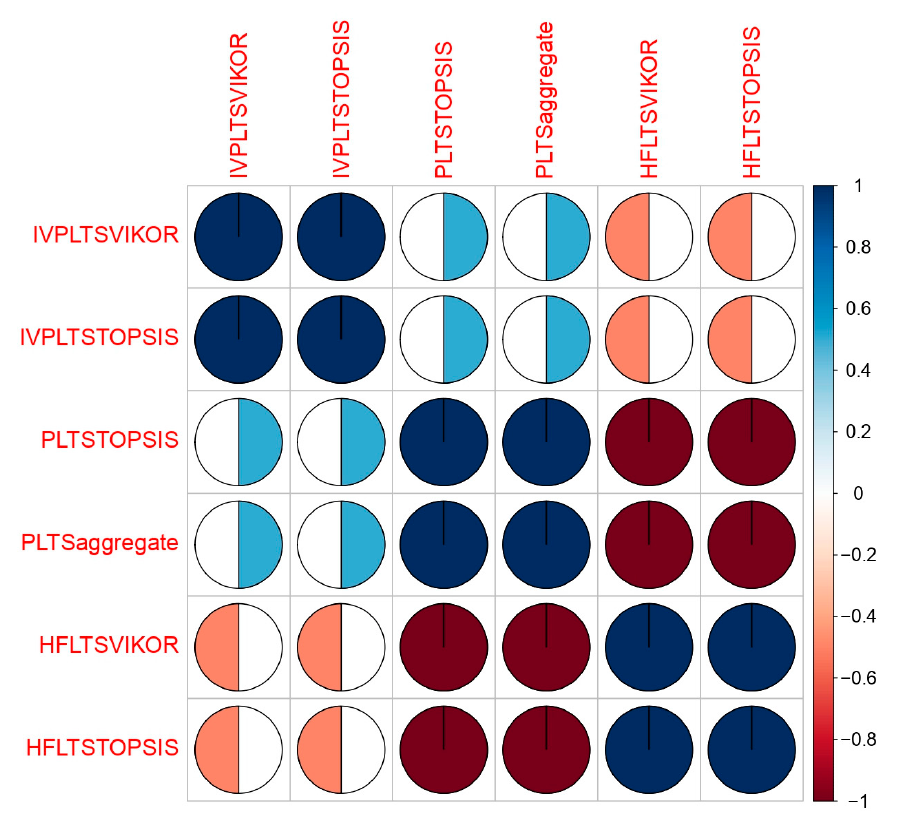
Figure 2. Spearman correlation for di ff erent ranking